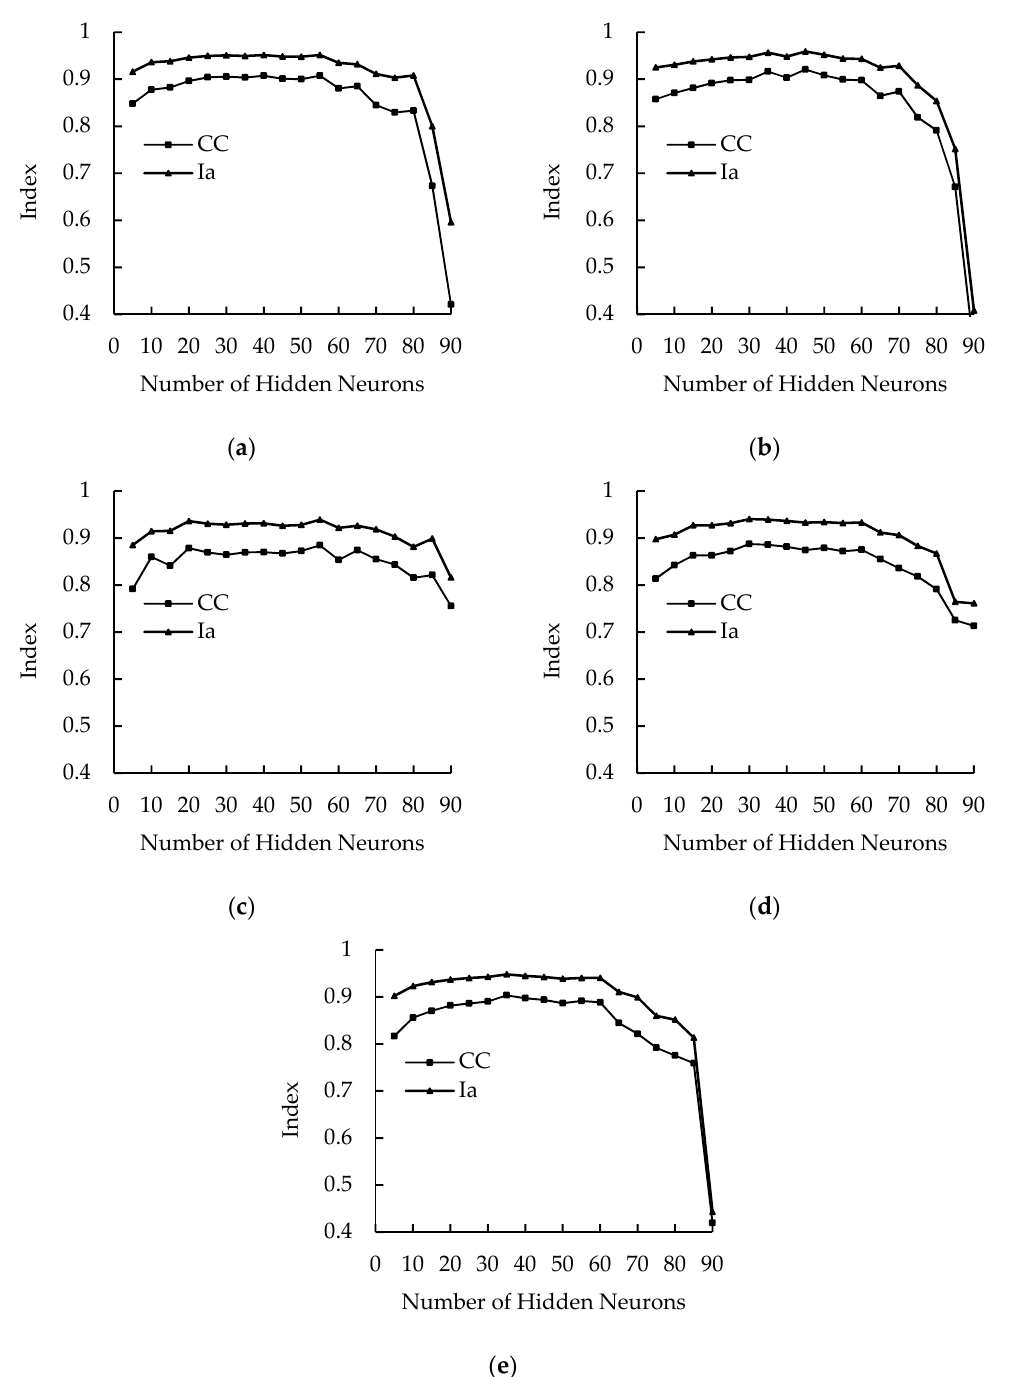
Figure 4. Performances of the ELM models with different hidden nodes: ( a ) Sigmoid function; ( b ) Sin function; ( c ) Hardlim function; ( d ) Tribas function; and ( e ) Radbas function.